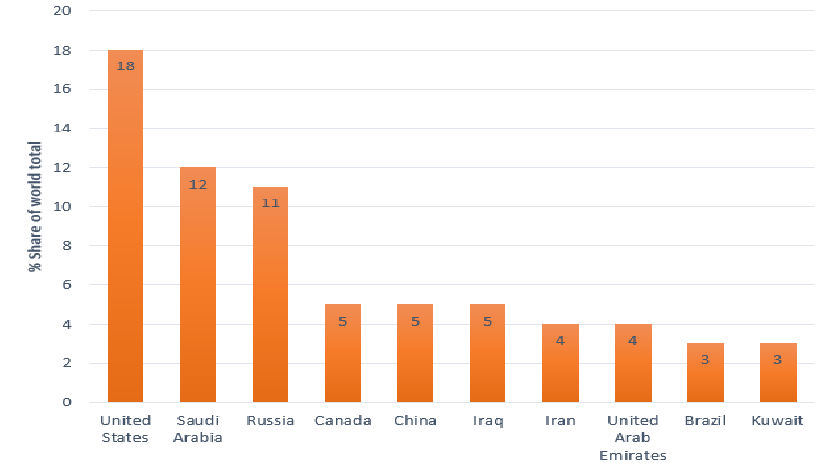
Figure 1. The largest oil producers’ countries and share of total world oil production in 2018.